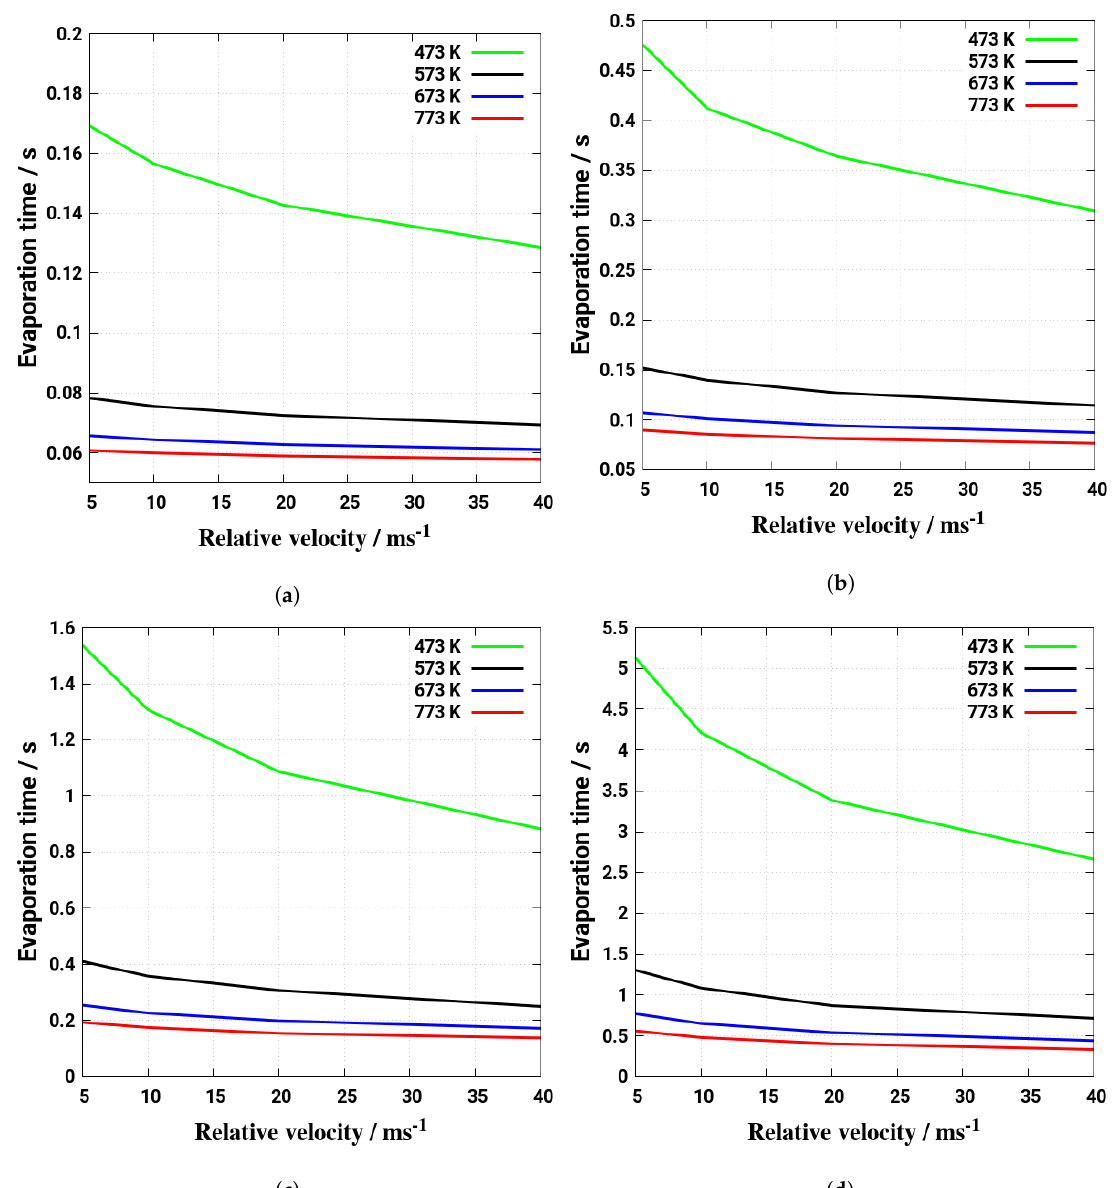
Figure 5. Influence of droplet relative velocity and gas temperature on evaporation dynamics for droplet diameters of: ( a ) 25 µ m; ( b ) 50 µ m; ( c ) 100 µ m; ( d ) 200 µ